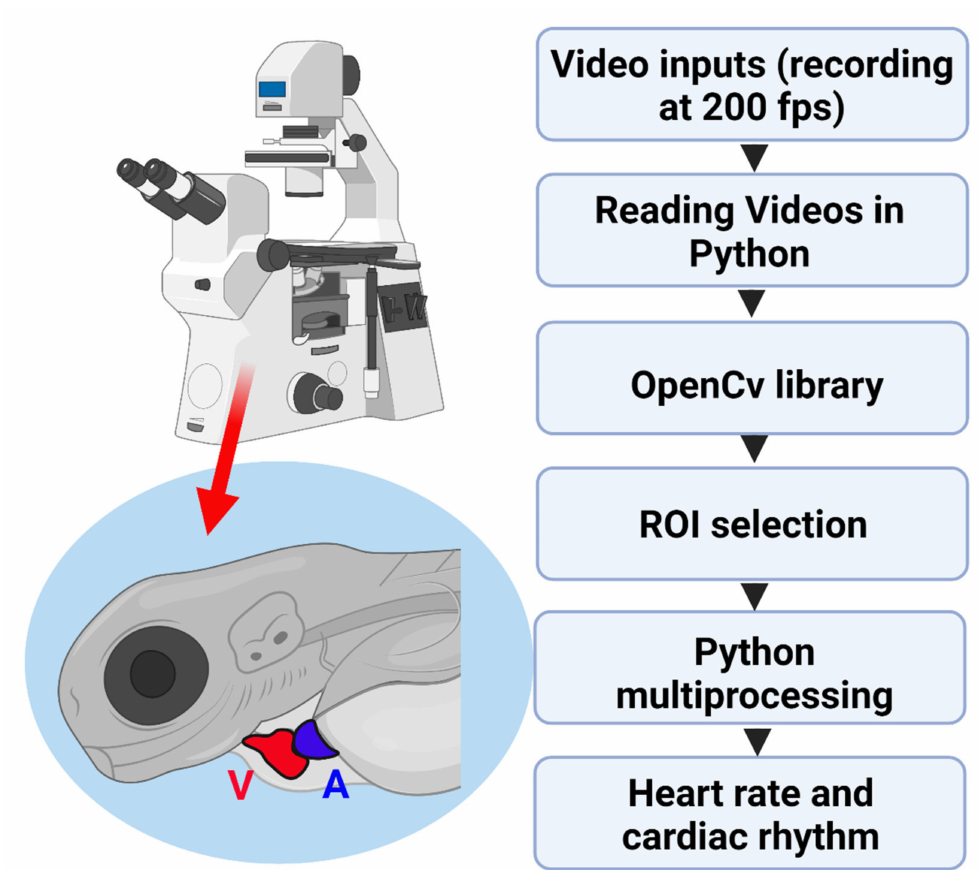
Figure 1. Schematic diagram showing the instrument setting and analysis pipeline for OpenCV-based cardiac rhythm detection in this study. A: atrium, V: